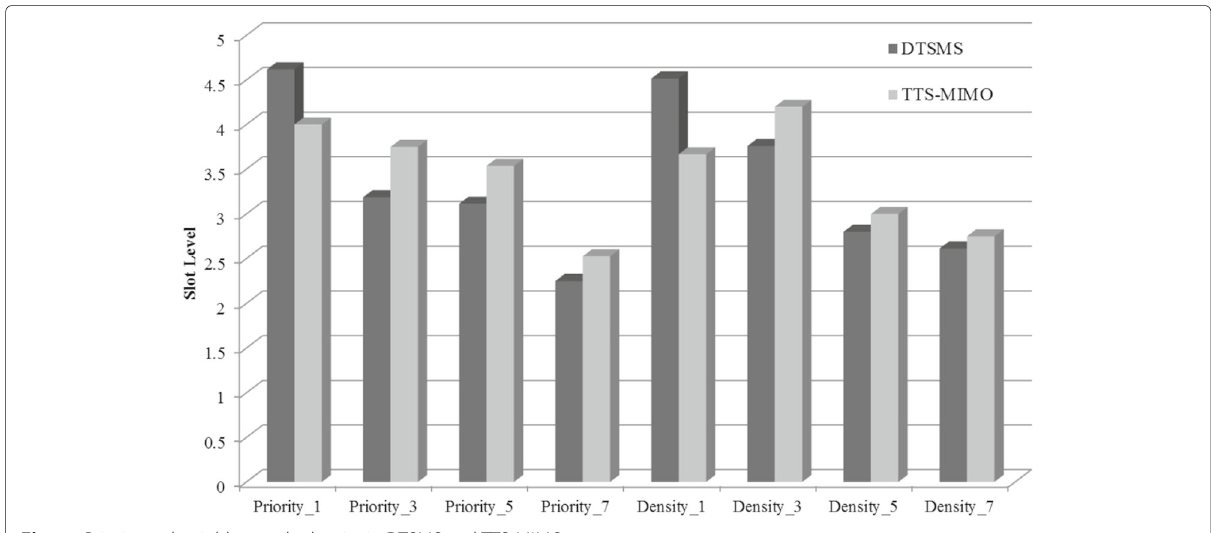
Fig. 11 Priority and neighbor node density in DTSMS and TTS-MIMO